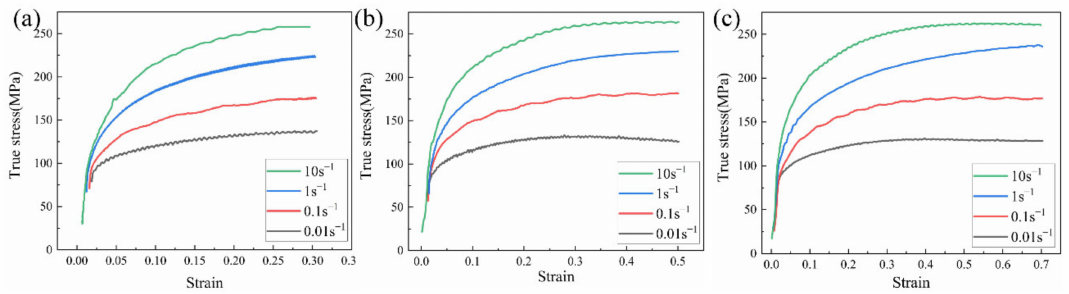
Figure 3. True stress–strain diagram for different strain variables at 950 ◦ C: ( a ) 0.3, ( b ) 0.5, ( c )